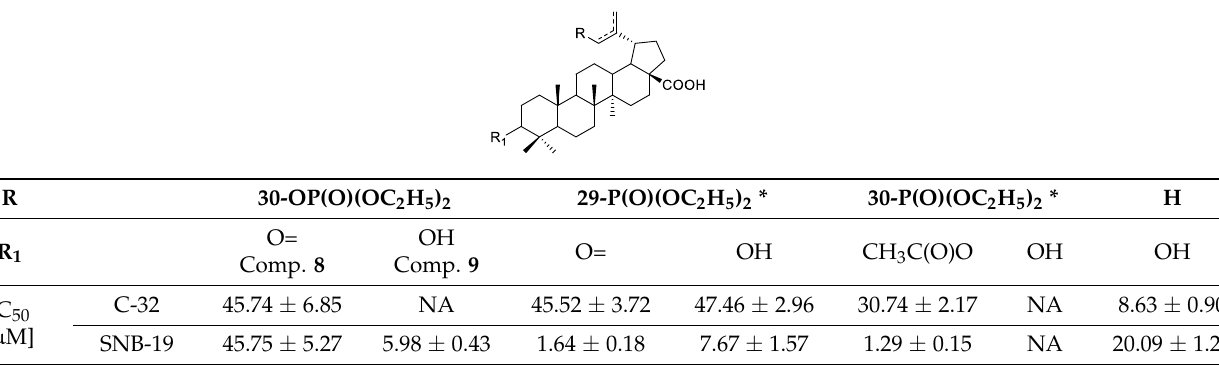
Table 5. Effect of 30-phosphate derivatives of betulonic acid 8 , betulinic acid 9 , and reference compounds on the viability of cells from two cancer cell lines studied (C-32 and SNB-19).